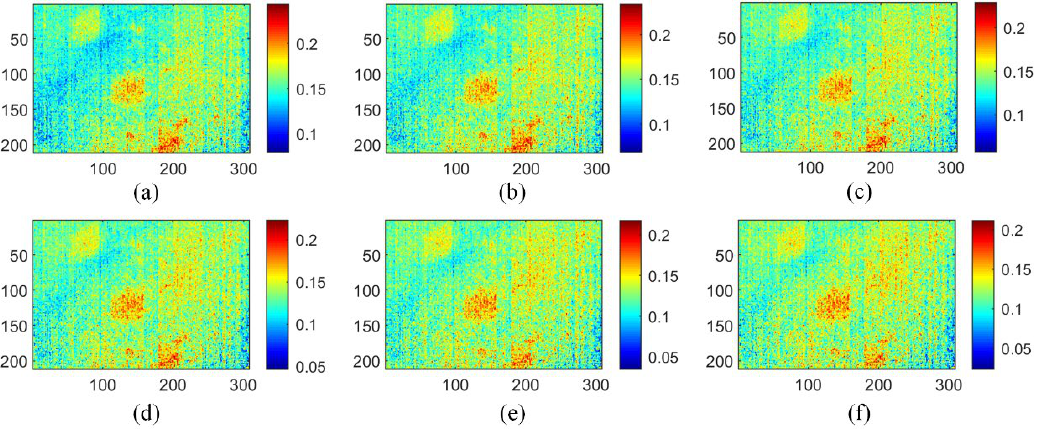
Figure 6. Reconstructed images of TSR method on three-defective CFRP sample: ( a ) first; ( b ) second; ( c ) fifteenth; ( d ) thirtieth; ( e ) sixty-second; ( f ) eightieth.